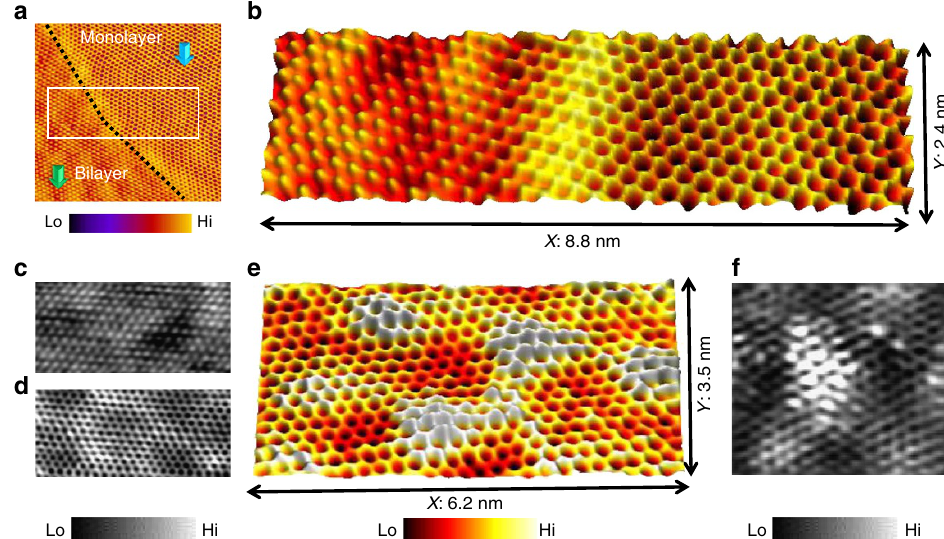
Figure 3 | Atomistic metrology of epitaxial graphene in liquid environment. ( a ) Wide-angle constant-current STM image revealing monolayer and bilayer graphene regions. The black line indicates the interface between the regions (Tunnelling parameters: I t ¼ 85pA, V b ¼ 1.1V, scan size: 9.4nm (cid:4) 8.7nm). ( b ) High-resolution constant current STM image showing the bilayer and monolayer regions within a single frame. (Tunnelling parameters: I t ¼ 65pA, V b ) ¼ 1.3V). ( c , d ) Constant-current STM image showing atomically clean lattice of bilayer and monolayer graphene, respectively. (Tunnelling parameters for c : I t ¼ 100pA, V b ¼ 0.9V, scan size: 5.2nm (cid:4) 2.5nm; and for d : I t ¼ 100pA, V b ¼ 1.1V, scan size: 5.8nm (cid:4) 2.7nm). ( e ) STM image highlighting